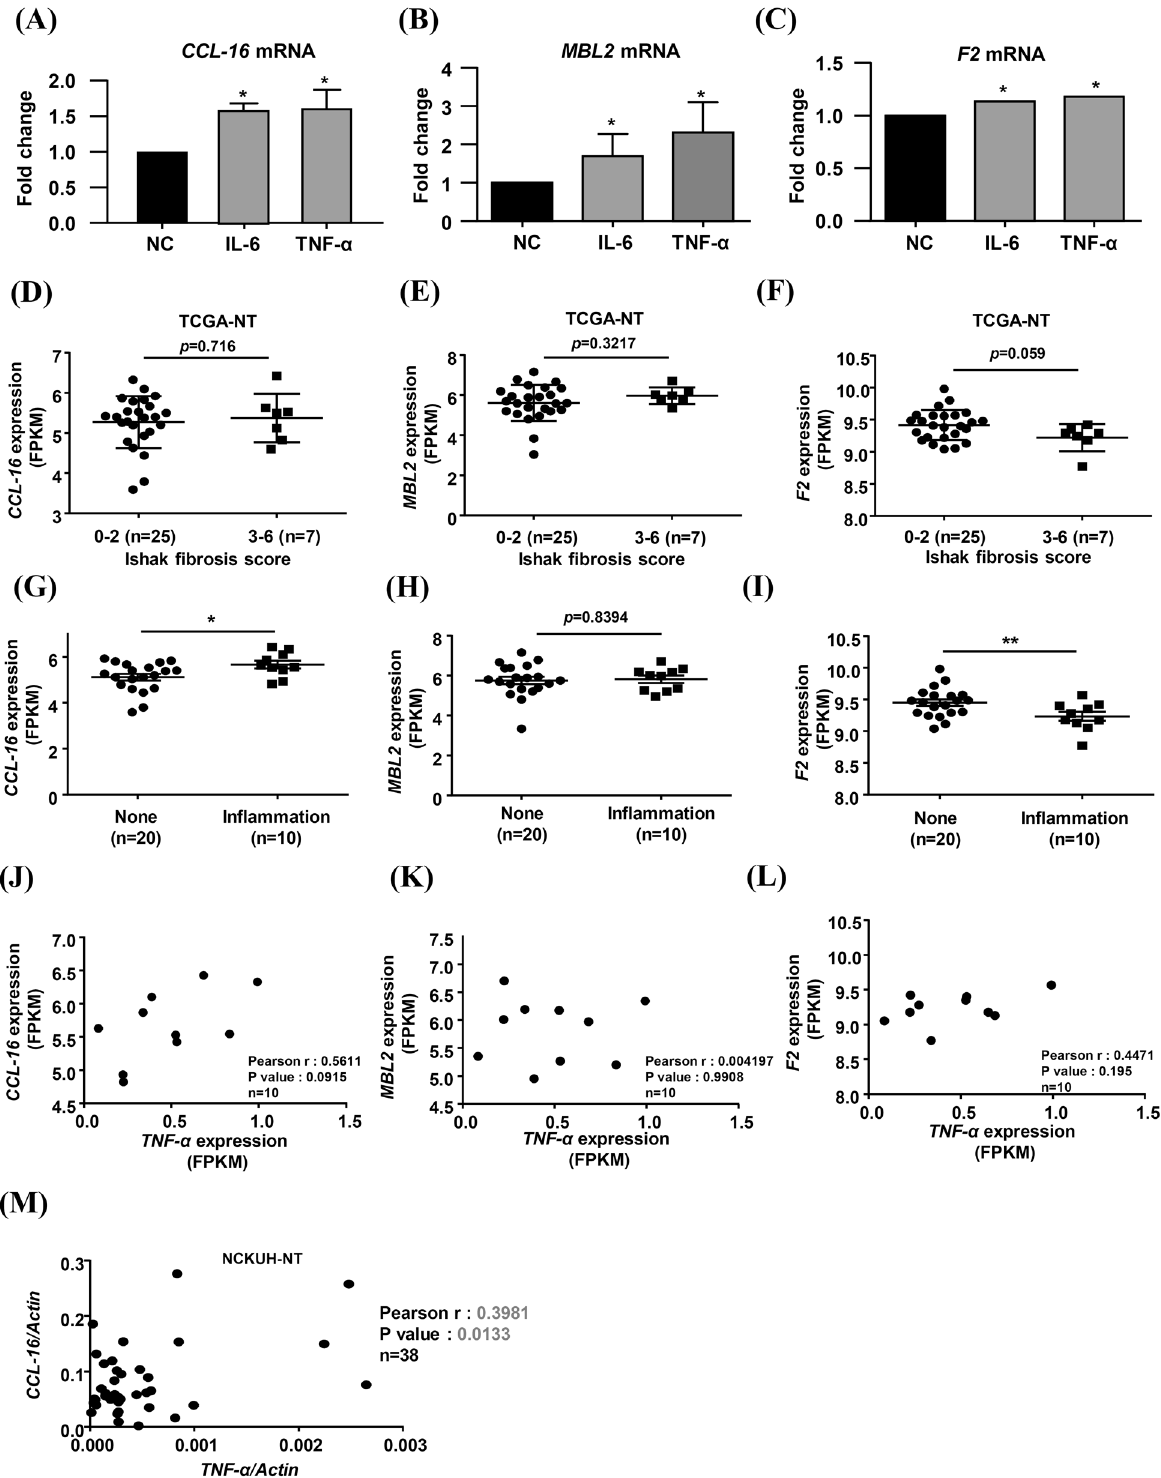
Fig. 6 Liver-secreted CCL-16 is positively correlated with TNF- α expression. A – C The expression levels of CCL-16 , MBL2 , and F2 mRNAs in human hepatocytes treated without (NC) or with IL-6 or TNF- α were determined by RT-qPCR. D – I The expression levels of CCL-16 , MBL2 , and F2 mRNAs in adjacent normal liver tissues (NT) of HCC patients from the TCGA-LIHC dataset with different Ishak fi brosis scores ( D – F ) and lymphocytic in fl ammation statuses ( G – I ) are shown. J – L Correlations between CCL-16 , MBL2 , and F2 mRNA levels and the TNF- α mRNA level in adjacent normal liver tissues with lymphocytic in fl ammation ( n = 10) from the TCGA-LIHC dataset were identi fi ed by the Pearson correlation coef fi cients. M The correlation between TNF- α and CCL-16 mRNA expression levels in the adjacent normal liver tissues of HCC patients ( n = 38) from the NCKUH cohort was identi fi ed by the Pearson correlation coef fi cient. * p < 0.05, ** p < 0.01.